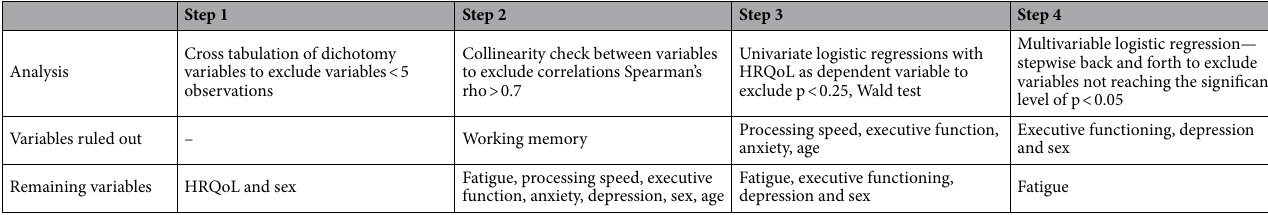
Table 2. Flow chart of 4 steps in the multivariable regression analysis in the participants with acquired brain injury, (n = 40). HRQoL Health Related Quality of Life. One participant was excluded from the regression analysis due to missing data concerning executive functioning.